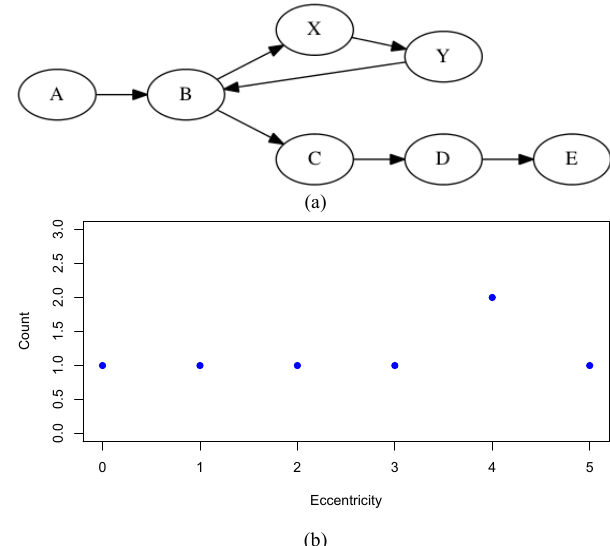
Fig. 3. Simple graph with a cyclic action (a) and its corresponding eccentricity distribution (b); the point (2,2) represents a peak in the distribution.